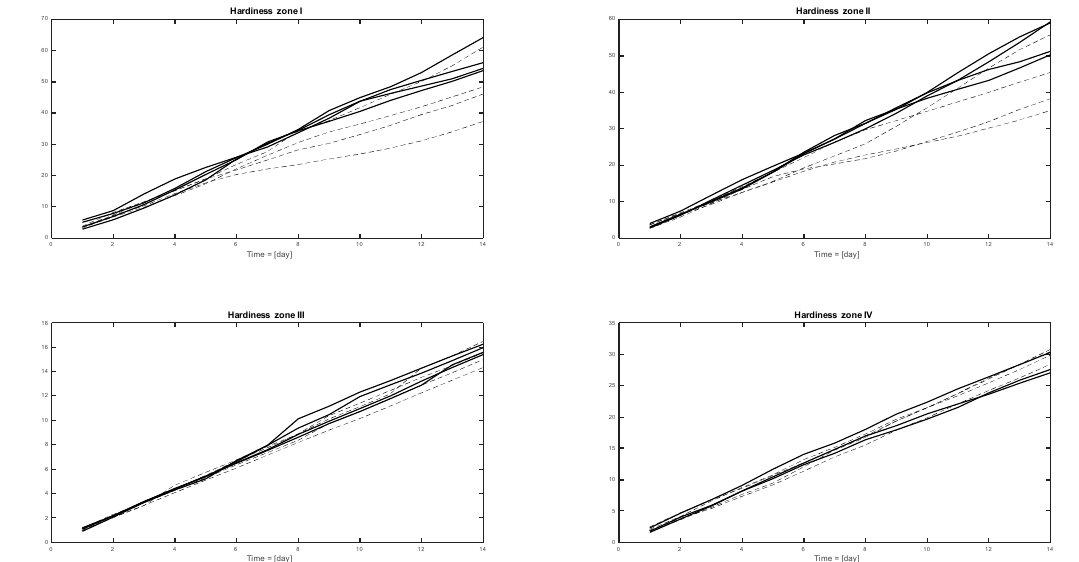
Figure 5. The cumulative summed feature values (y-axis) generated from weather data of the different hardiness zones. The category 0 data (four years’ data in hardiness zones I, II and III, and three years data in hardiness zone IV) are marked with a solid line and category 1 data (four years in each hardiness zone) with a dashed grey line. The observation period is 14 days, t 0 is the beginning of growing season, and the time step is one day (x-axis).